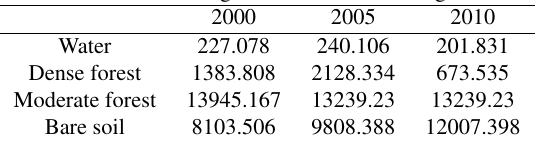
Table 1: Area changes across different categories